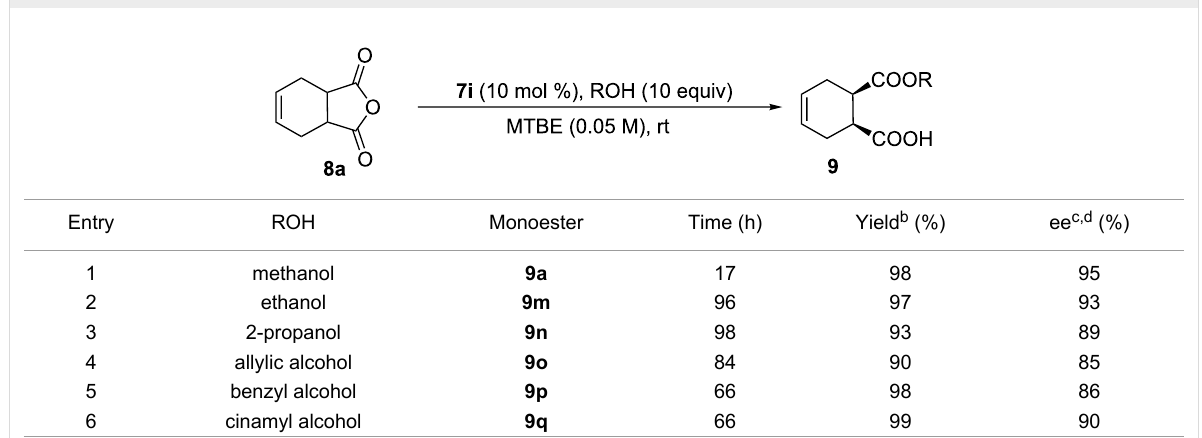
Table 3: Asymmetric alcoholysis of anhydride 8a with various alcohols. a